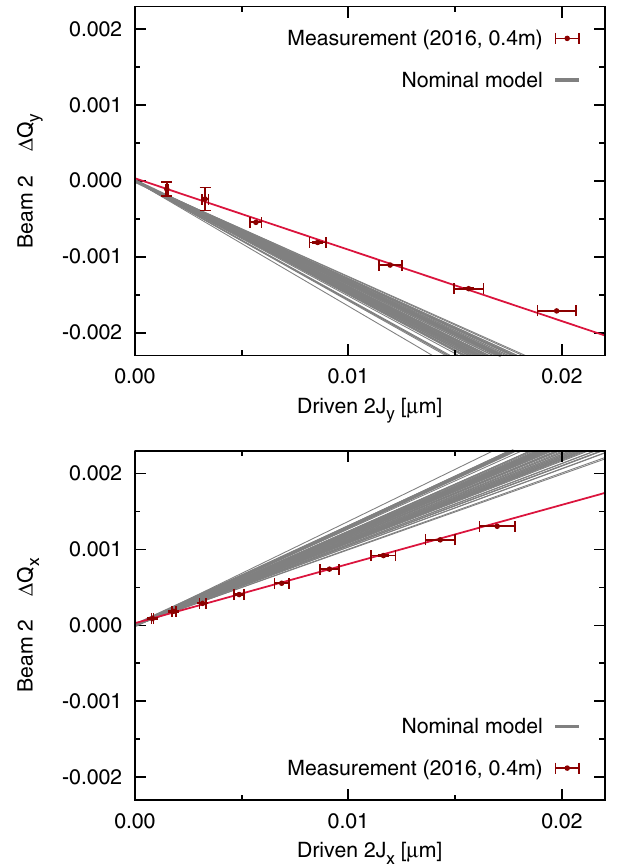
FIG. 5. Amplitude detuning measured with flat orbit in 2016, for LHC Beam 2 at β (cid:1) ¼ 0 . 4 m with Landau octupoles powered off (red). Simulated detuning is shown in gray, for models based upon the measured magnetic errors. Sixty instances of the magnetic errors are simulated, corresponding to the uncertainty in the magnetic ∂ Q y Fig. 5. Direct terms ( ∂ Q x and ) showed a ∼ 30% ∂ ϵ x ∂ ϵ y discrepancy relative to magnetic measurements. On their